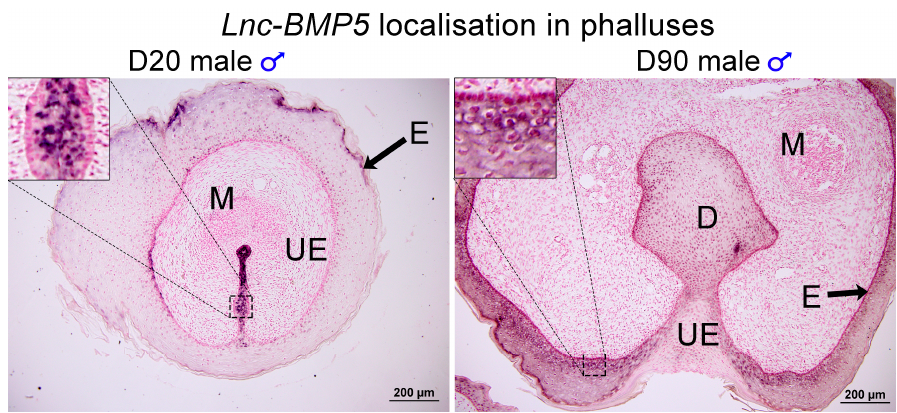
Figure 4. Lnc-BMP5 mRNA localisation in day 20 pp and day 90 pp male phalluses. Lnc-BMP5 was detected in the nucleus of urethral epithelial cells of male phalluses at day 20 pp and in male phallus epithelium at 90 pp. D: diverticulum, E: epithelium, M: mesenchyme, UE: urethral epithelium. Scale bar: 200 µm.